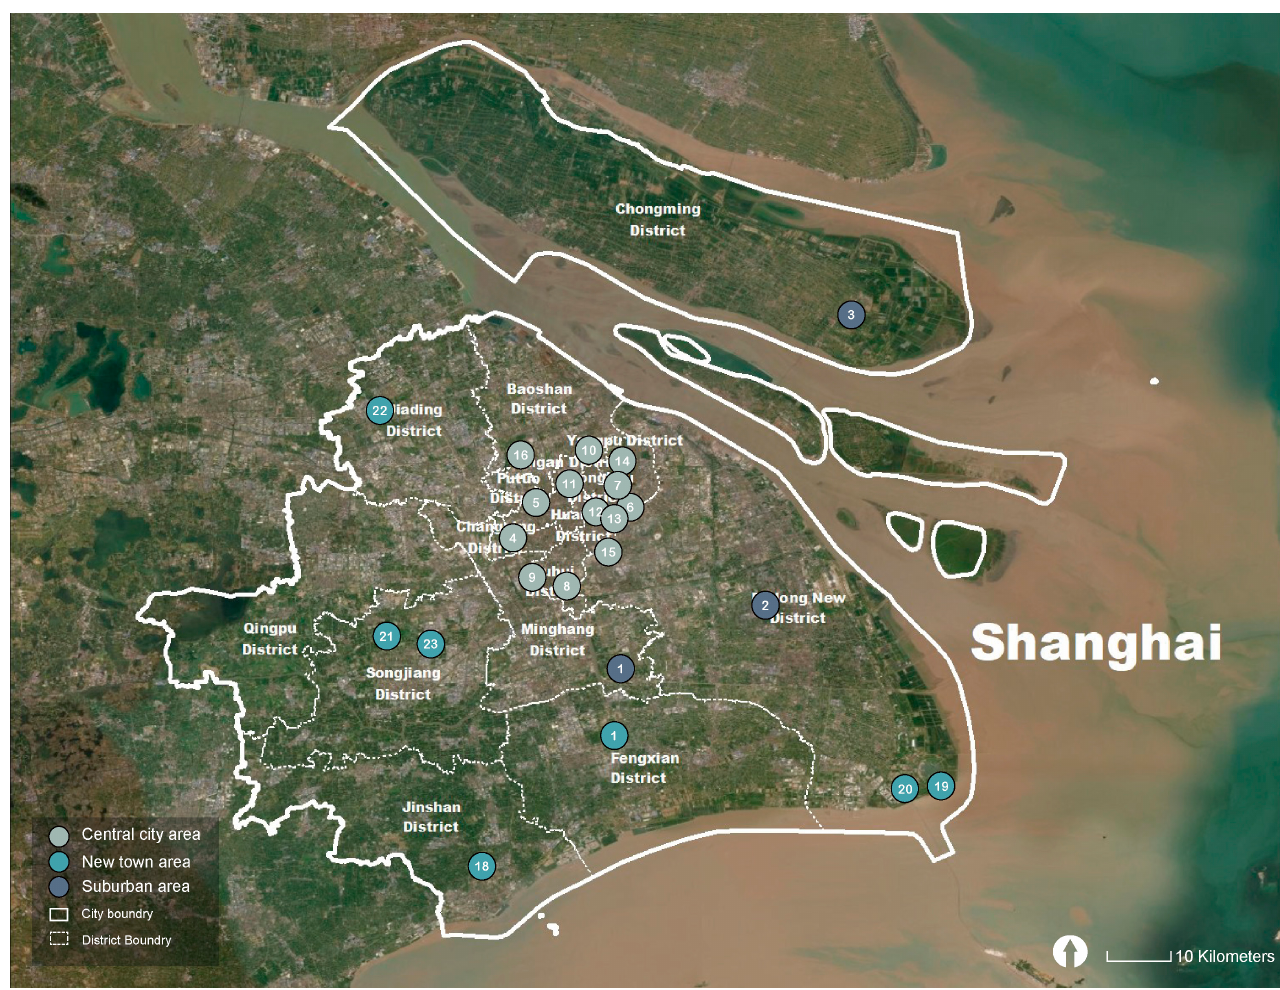
Figure 1. Locations of the selected SPC